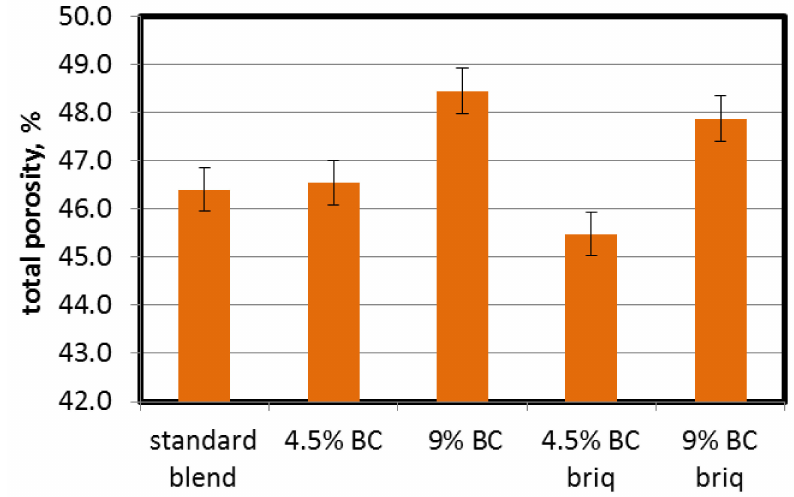
Figure 7. Influence of lignite addition on total porosity of